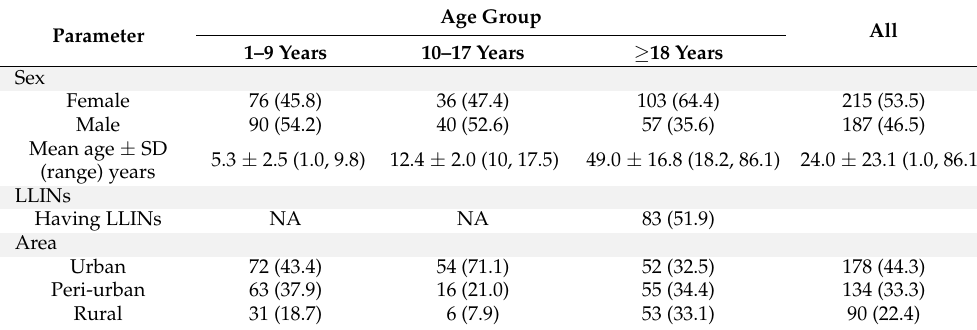
Table 1. Demographic characteristics of the study